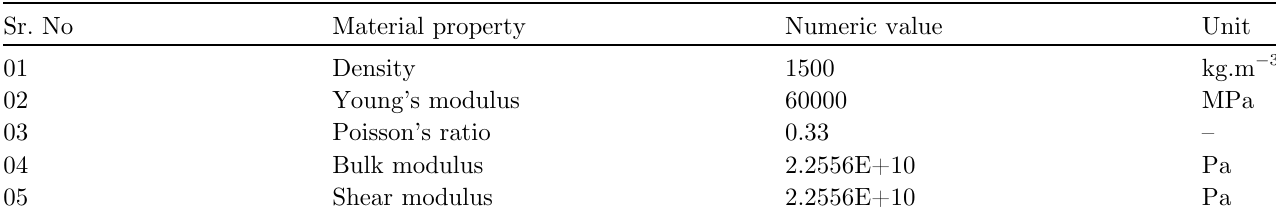
Table 1. Material property for nickel-titanium alloy.